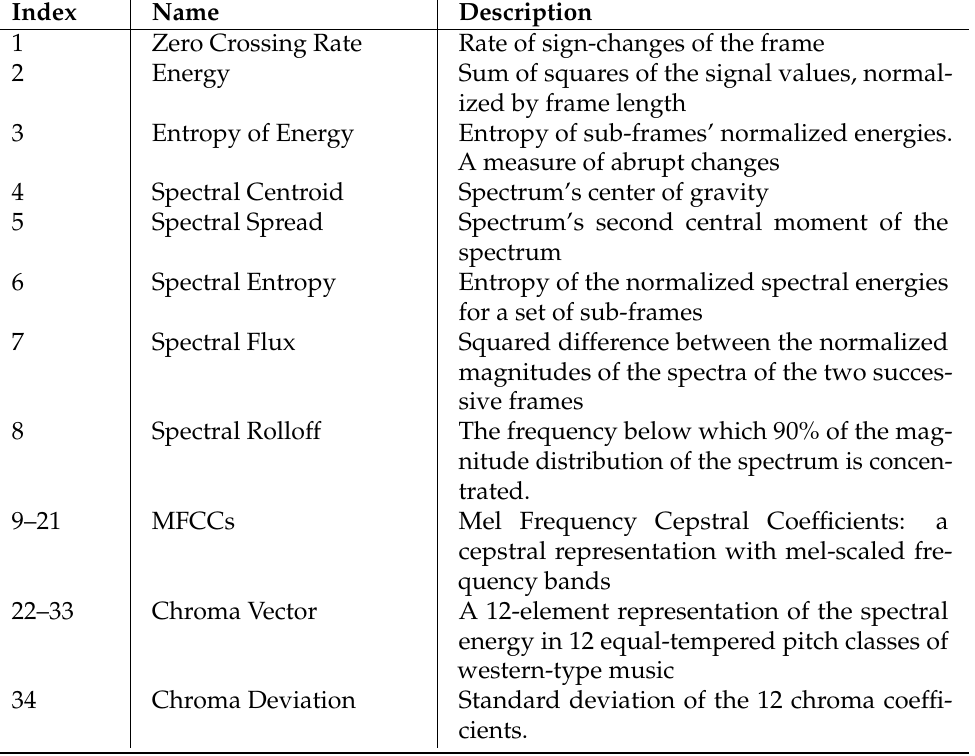
Table 1. Adopted short-term audio